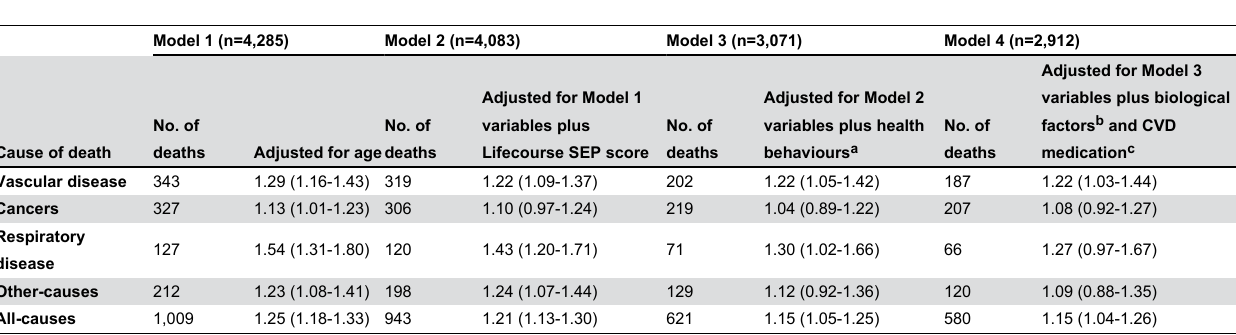
Table 4. Hazard Ratio (95%CI) of cause-specific death per 1-SD increase in the IMD